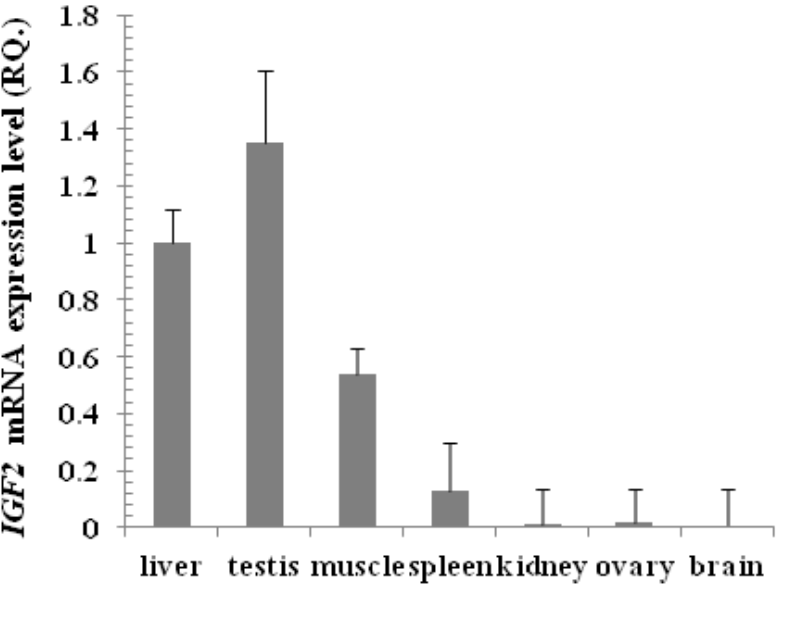
Figure 12. Expression of yak IGF2 was detected by Real time PCR from different tissues. The results were expressed relative to liver as calibrator and using the GAPDH as housekeeping